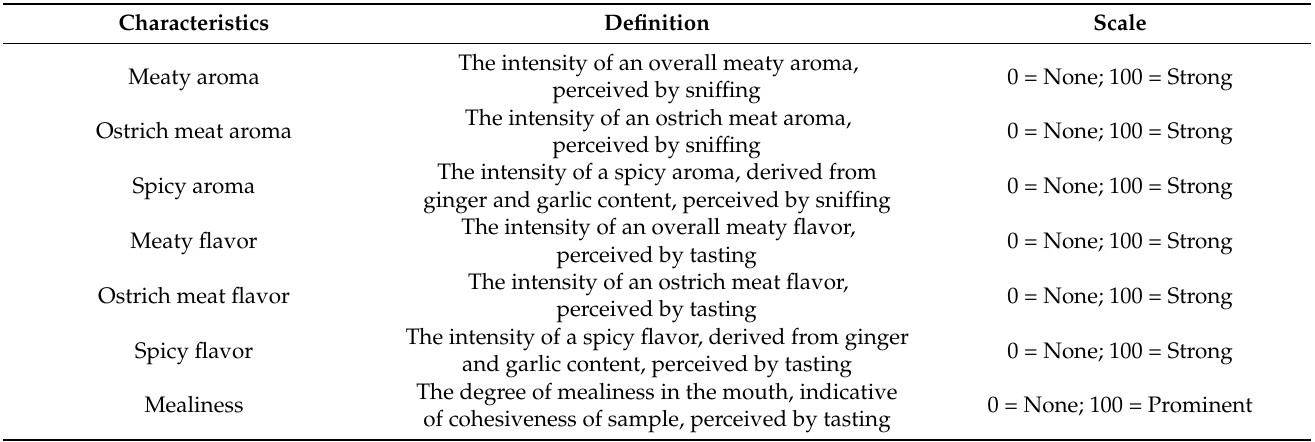
Table 2. Definitions of sensory characteristics for descriptive sensory analysis of five ostrich ham treatments.